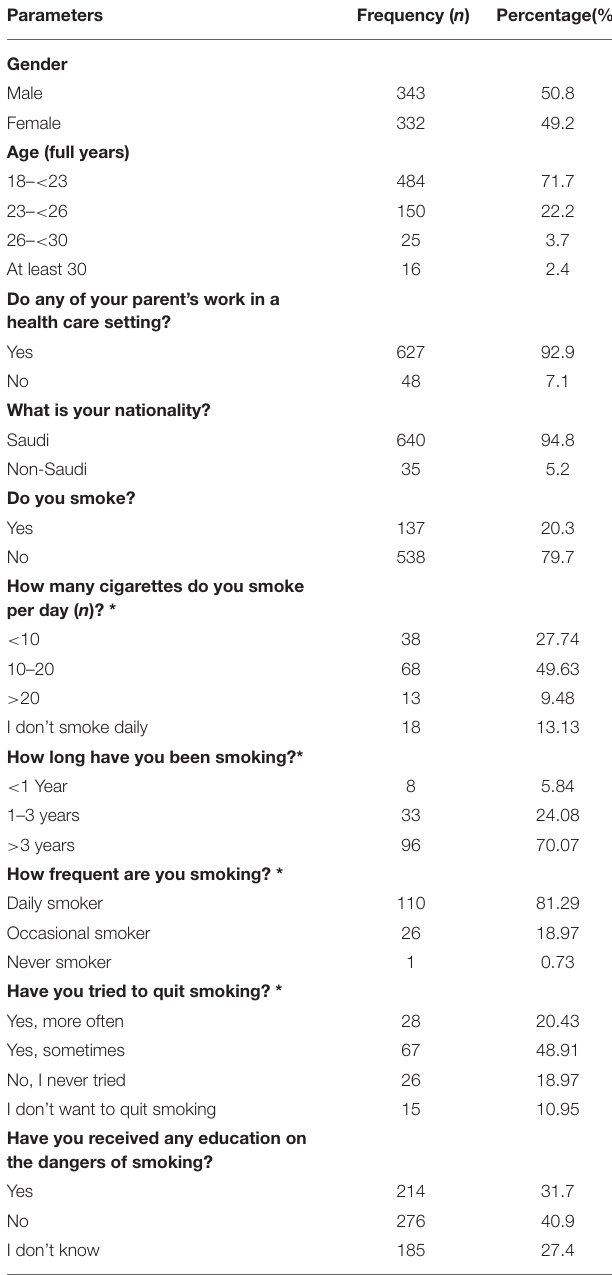
TABLE 1 | Demographic characteristics and smoking behavior among 675